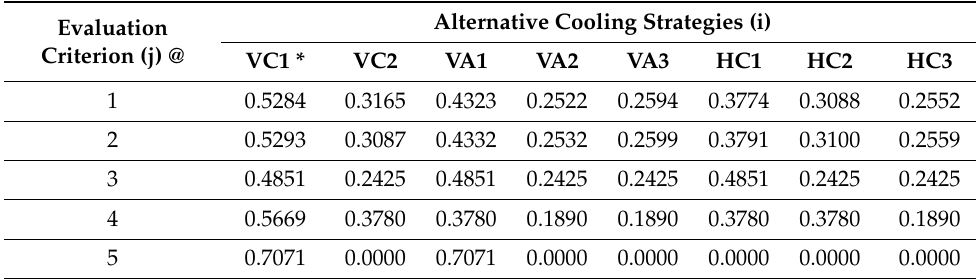
Table 11. Normalized decision matrix R